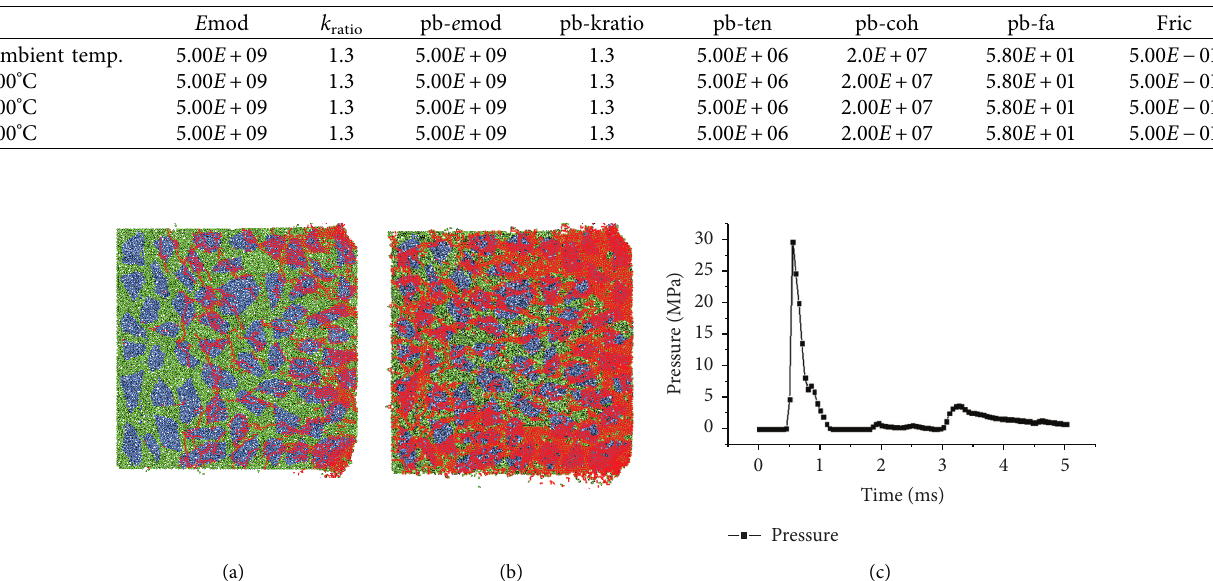
Table 7: Contact parameters of particles in the aggregate cluster.